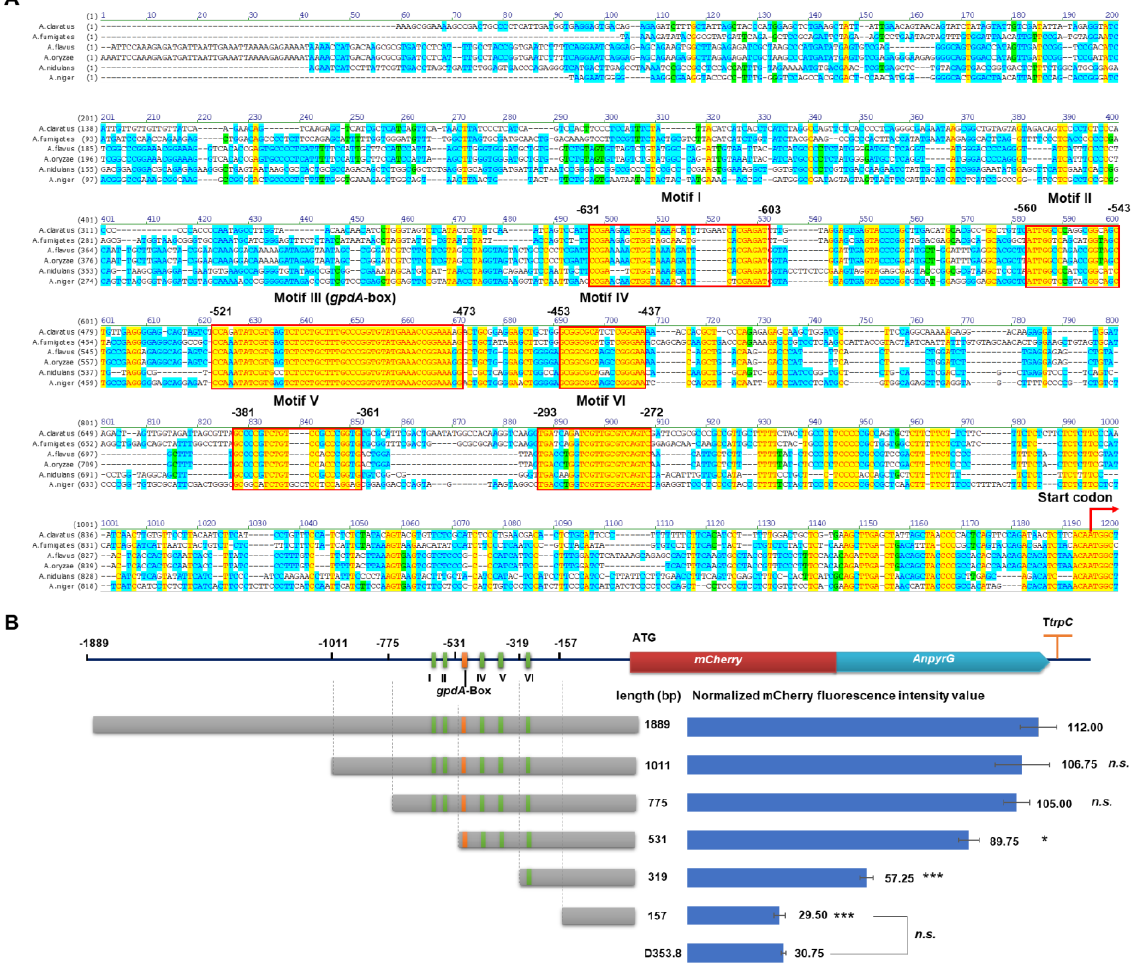
Figure 3. Characterization of essential elements of the P gpdAg promoter. ( A ) Multiple sequence alignment of the P gpdA promoters of various Aspergilli spp . The GenBank accession numbers of the selected gpdA genes included A. niger CBS 513.88 (An16g01830), A. nidulans FGSC A4 (ANIA_08041), A. clavatus NRRL1(ACLA_003290), A. fumigatus Af293 (AFUA _5G01970), A. flavus NRRL 3357 (AFLA_025100), and A. oryzae RIB40 (AO090003001322). The conserved motifs are highlighted with red boxes. The transcription start site and start codon are shown as red arrows. ( B ) The conserved motifs ’ prediction and truncation test of P gpdAg promoter in A. niger. GpdA-box and five predicted conserved motifs are represented as orange bars and green bars, respectively. The truncation design of the P gpdAg promoter is displayed as gray bars. The mean mCherry fluorescence intensity of each truncation is shown as blue bars. Results are the mean of three replicates, and error bars indicate standard deviations ( n = 4). Pairwise Student ’ s t -test were conducted between P gpdAg truncated mutant relative to the full-length P gpdAg reported strain and between the mutant only containing UTR and the parent strain, respectively. The p values are indicated as (>0.05, n.s. ; * < 0.05; *** < 0.001). 3.4. Application of PgpdAg Dramatically Improved Citric Acid Production in A. Niger To assess industrial application of the endogenous P gpdAg promoter, we chose a cit- rate exporter cexA as an engineering target for citric acid production. The donor DNAs with cexA controlled by P gpdAd , P gpdAg and its truncated mutant P gpdAg -775 were inte- grated at the agdA gene locus, respectively (Figure 4A). After verified by the genomic PCR diagnosis and sequencing analysis of the four selected transformants (Figure S3), two iso- lates of each construction were selected for citric acid fermentation in shake flasks. As